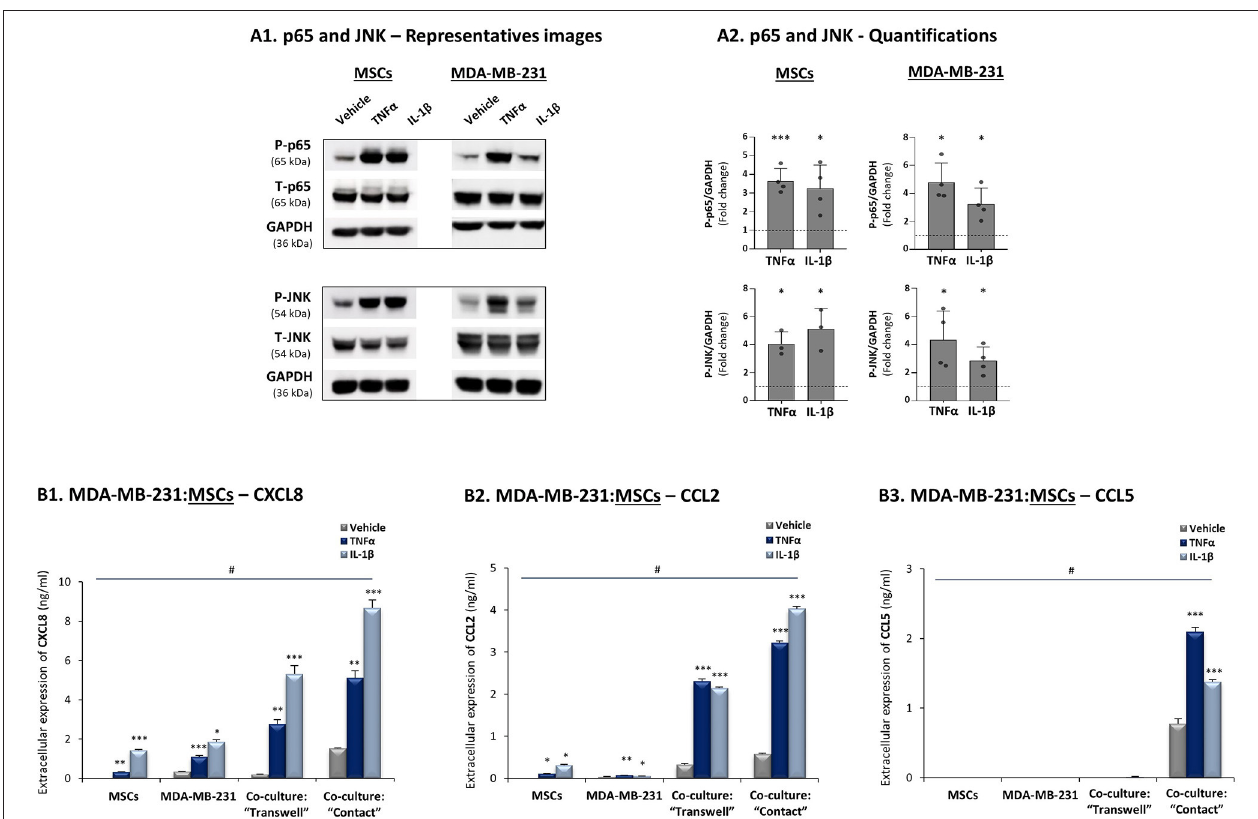
FIGURE 3 | CXCL8, CCL2 and CCL5 reach their highest expression levels when TNBC:MSC “Contact” co-cultures are stimulated by TNF α or IL-1 β . (A) Activation of p65 and JNK, determined by WB in MSCs and in human TNBC MDA-MB-231 cells upon 15min stimulation by TNF α , IL-1 β or vehicle control (based on kinetics and titration studies. Information on cytokine concentrations is given in “Materials and methods”). GAPDH was used as a loading control. (A1) A representative experiment and (A2) averages ± SD of p65 and JNK activation (fold induction) in n ≥ 3 independent experiments, performed with MSCs of 2 different donors. *** p < 0.001, * p ≤ 0.05 for differences between the values obtained for cytokine-stimulated cells and control non-stimulated cells. Dashed line stands for the value of 1 given to control cells. (B) CXCL8 (B1) , CCL2 (B2) and CCL5 (B3) expression levels were determined in TNBC:MSC co-cultures or each of the cell types grown alone, with or without TNF α or IL-1 β stimulation. Co-cultures of MDA-MB-231 cells with MSCs were generated in “Transwell” and “Contact” conditions and were stimulated by TNF α (10ng/ml), IL-1 β (350 pg/ml) or vehicle control (similar for both cytokines) for 7h. After change of media and growth for additional 60h, the extracellular expression of CXCL8 in TNF α /IL-1 β -free CM was determined by ELISA. *** p ≤ 0.001, ** p ≤ 0.01, * p ≤ 0.05 for differences between TNF α - or IL-1 β -stimulated cells and vehicle-treated cells, within each group. # p -values were < 0.01 or < 0.001 (in most cases) in comparisons of “Contact” co-cultures with all other treatments, as well as in comparisons of “Transwell” co-cultures with all other treatments. The results are of a representative experiment of n ≥ 3 independent experiments, performed with MSCs of 3 different